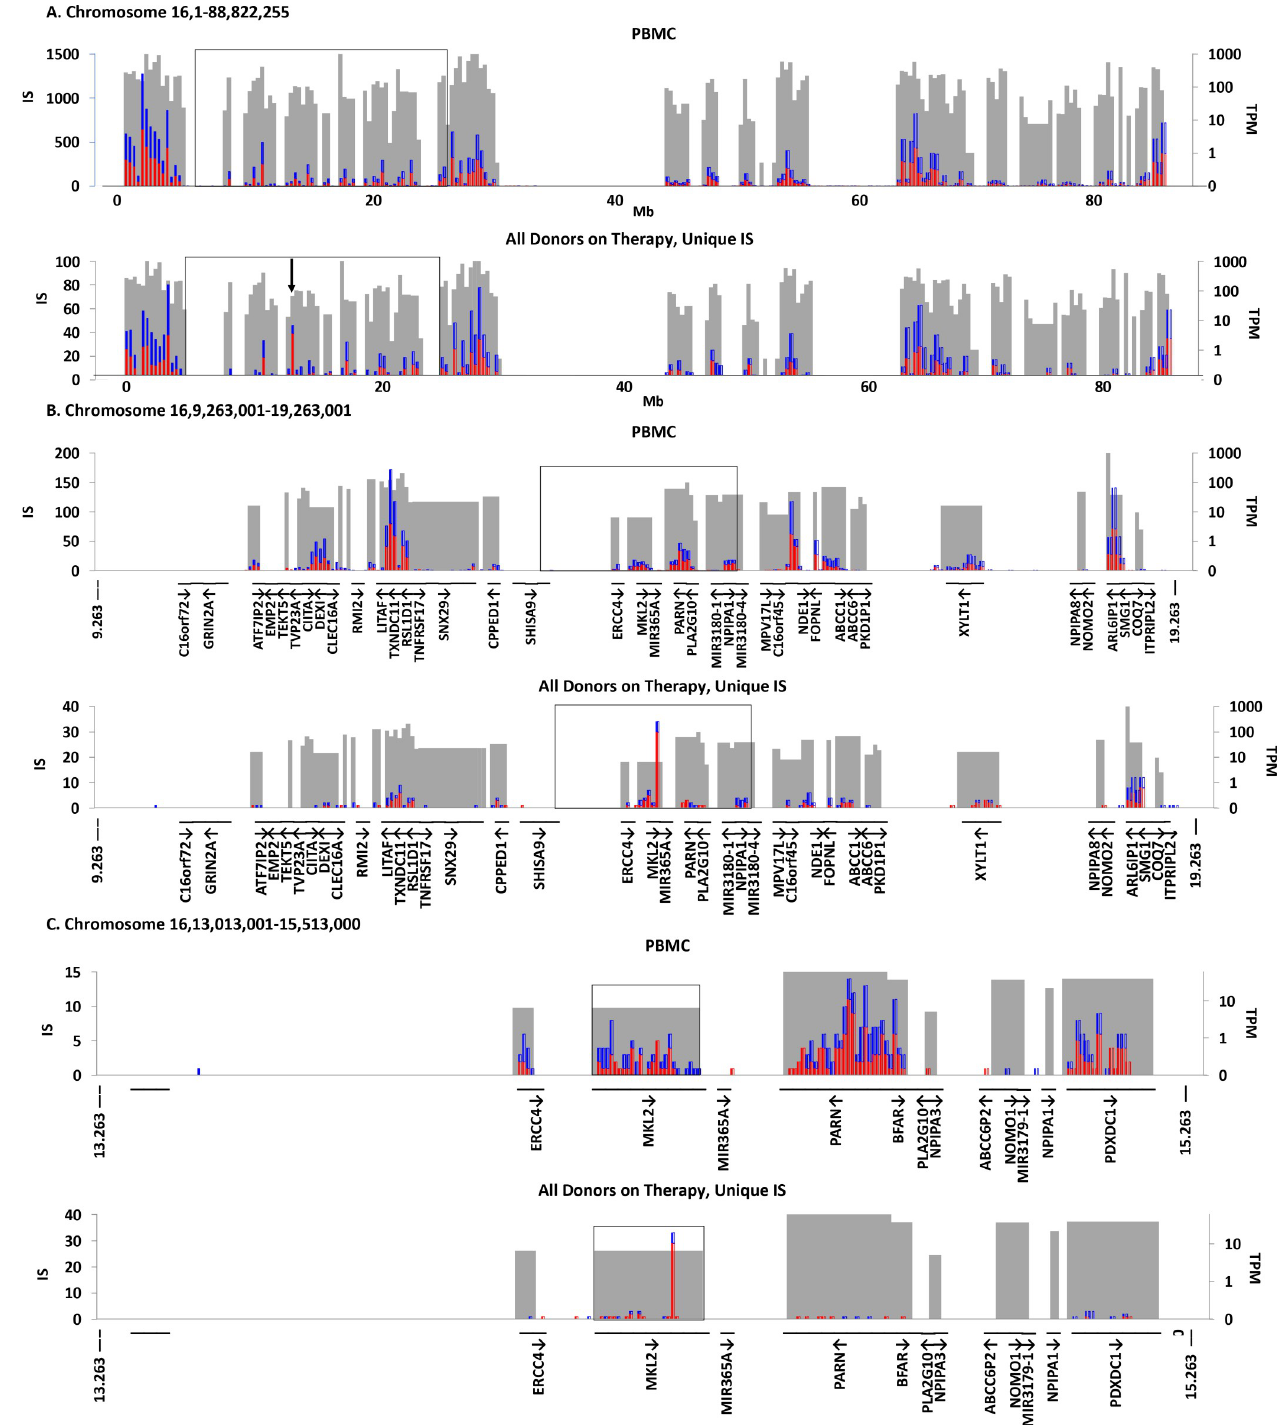
Fig 3. Analysis of IS in MKL2. Using the Excel-based application described in S2 Fig, a selected region of the genome of any size is divided into 250 bins. The IS in each bin are tabulated and the number of IS in the bin is shown as a bar, with the orientation of the provirus relative to the numbering of the chromosome indicated by color (red for the same as the chromosome and blue for the opposite). The grey boxes indicate the location and relative RNA level of the genes in each bin. RefSeq genes (from the hg19 sequence database) are shown at the bottom of each plot, with arrows indicating their orientation relative to the numbering of the chromosome. The figure shows the distribution of genes and IS on chromosome 16 at 3 different scales. In all panels, the top image shows the distribution of IS from PBMC infected in vitro; the bottom, the distribution of the unique IS data from on-ART donors. A. Entire chromosome 16